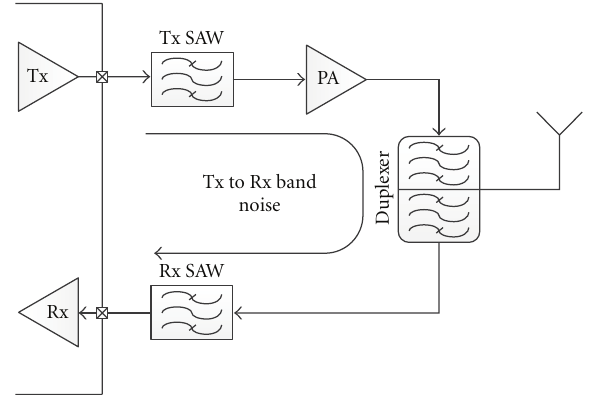
Figure 13: Diagram showing Tx signal leakage in a conventional transceiver.